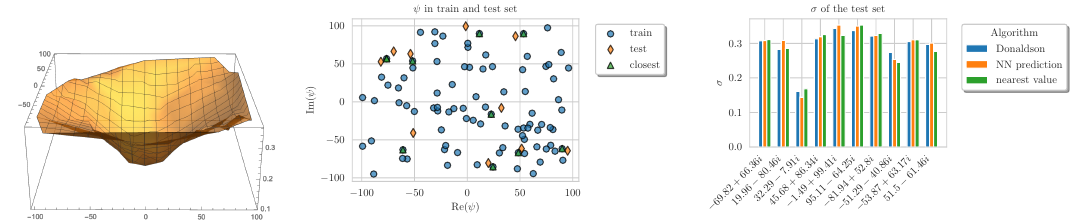
Figure 2 . ( Left ): errors σ for Donaldson’s algorithm as a function of ψ for random sampling. ( Middle ): values of ψ used in the training and evaluation set. ( Right ): comparison of σ for different approximation approaches.